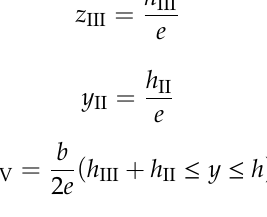
Figure 3. Flow partition in a rectangular channel ( k < 2h / b ).